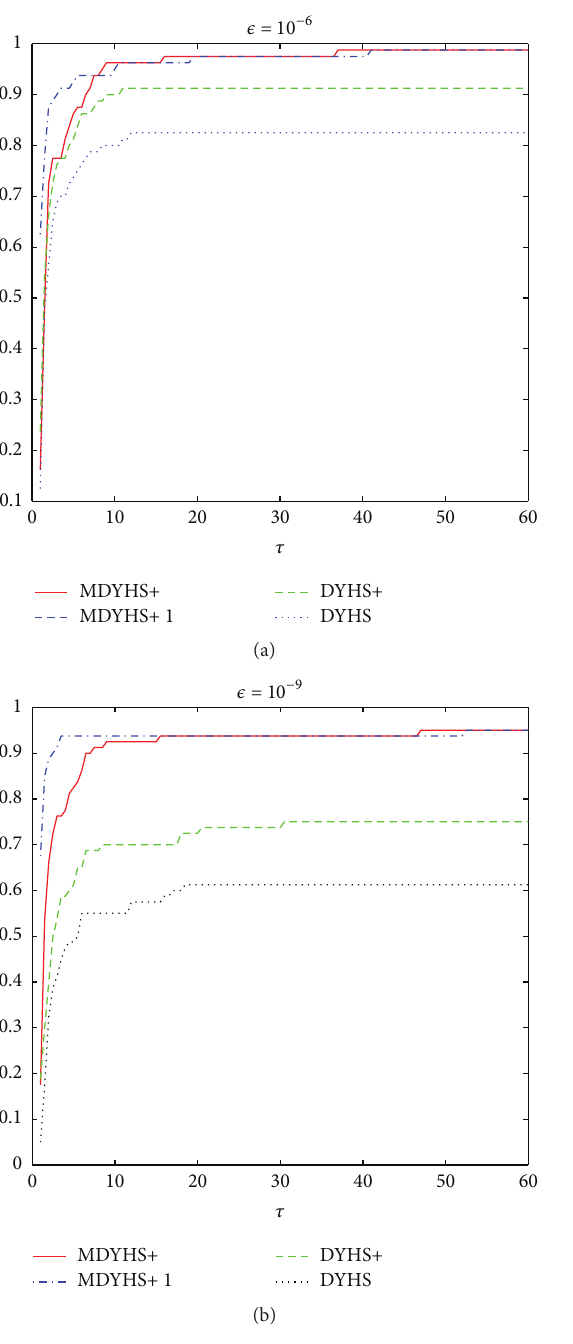
Figure 2: Performance profiles based on the number of iterations. Figure 3: Performance profiles based on the number of inner